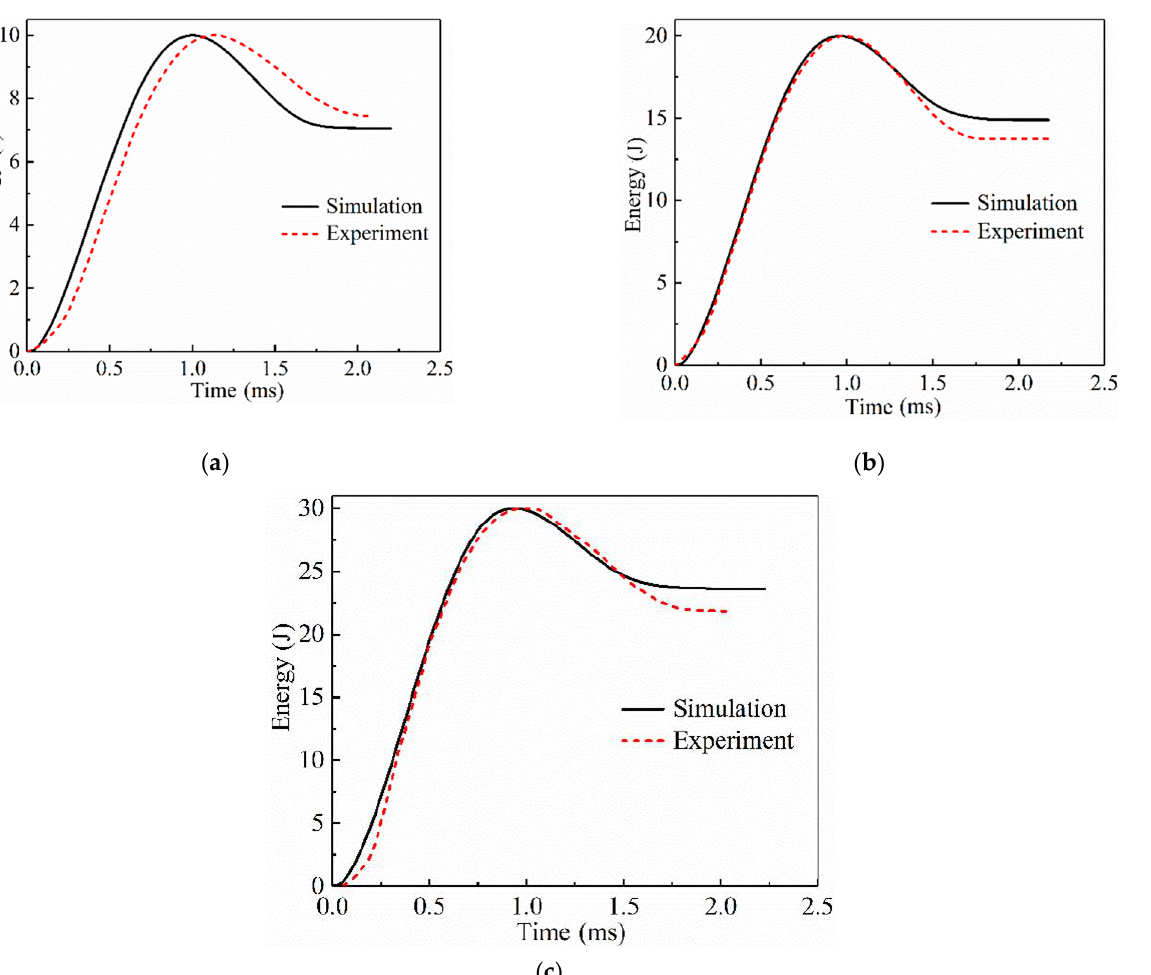
Figure 7. Curves of the energy absorption-time of the SLJs adhesively bonded structure of CFRP laminate under different impact energies. ( a ) 10 J; ( b ) 20 J; ( c ) 30 J.